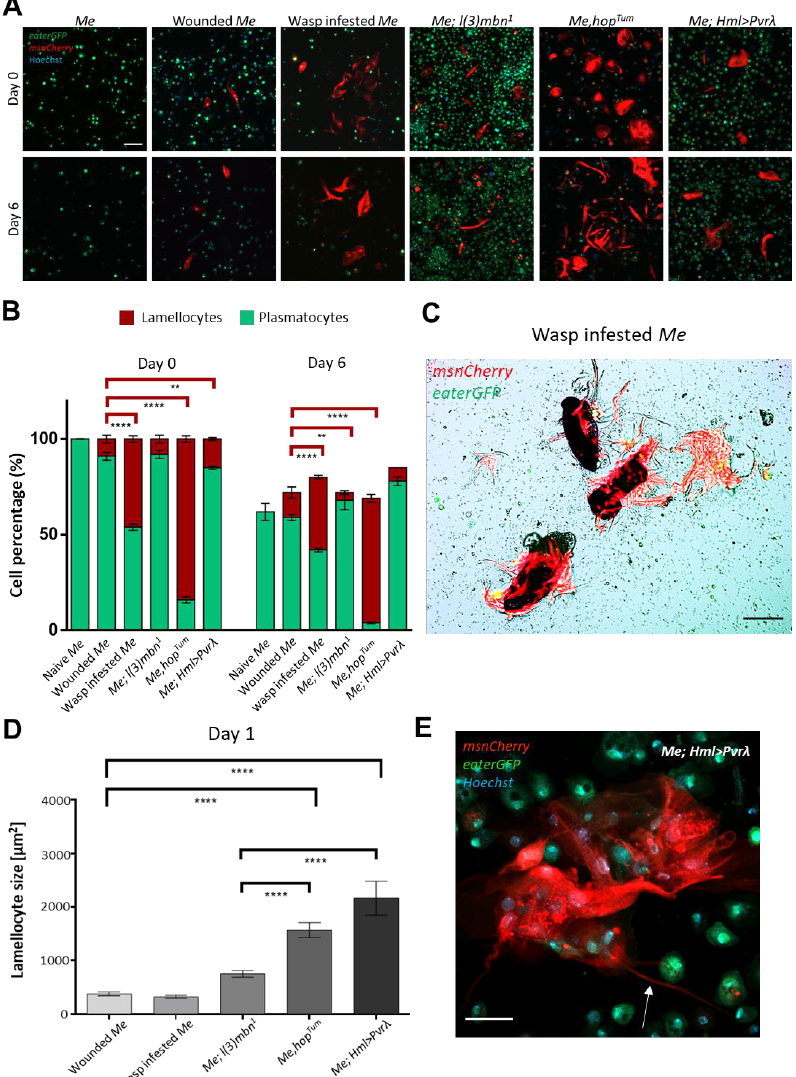
Figure 2. Hemocyte composition and morphology in primary larval blood cell cultures. ( A ) Repre- sentative images of hemocyte cultures of naive, wounded, and wasp-infested Me , and tumorous Me; l(3)mbn 1 , Me,hop Tum and Me; Hml>Pvr λ at the day of isolation (Day 0, 16 h after immune induction in case of wounded and wasp infested Me ) and 6six days after (Day 6) (blue: nuclei, green: plasmato- cytes, red: lamellocytes). Scale bar: 20 µ m. ( B ) Bar graph showing the percentage of plasmatocytes and lamellocytes (ratio of GFP or Cherry positive cells on Day 0 or 6 to the GFP+Cherry positive cells on Day 0 in the same culture) in naive, wounded, and wasp infested Me , and tumorous Me; l(3)mbn 1 , Me,hop Tum and Me; Hml>Pvr λ cultures on Day 0 and Day 6. Cells in three fields of view at a 10 × objective were counted from each sample (n = 3), and the data are the mean ± SD of three indepen- dent experiments. Data were analyzed using ANOVA with Tukey’s test for multiple comparisons, ** p ≤ 0.01, **** p ≤ 0.0001. ( C ) Lamellocytes on the surface of isolated parasitoid wasp eggs in a wasp-infested Me culture 48 h after culturing (green: plasmatocytes, red: lamellocytes). Scale bar: 100 µ m. ( D ) Bar graph showing lamellocyte size in hemocyte cultures of wounded and wasp infested Me , and tumorous Me; l(3)mbn 1 , Me,hop Tum and Me; Hml>Pvr λ , data are mean ± SD of the size of 50 lamellocytes. Data were analyzed using ANOVA with Tukey’s test for multiple comparisons, **** p ≤ 0.0001. ( E ) Filopodium-like structures typical of lamellocytes in blood cell cultures of Me; Hml>Pvr λ larvae on Day 1 of culturing (blue: nuclei, green: plasmatocytes, red: lamellocytes, arrow indicates filopodium). Scale bar: 20 µ